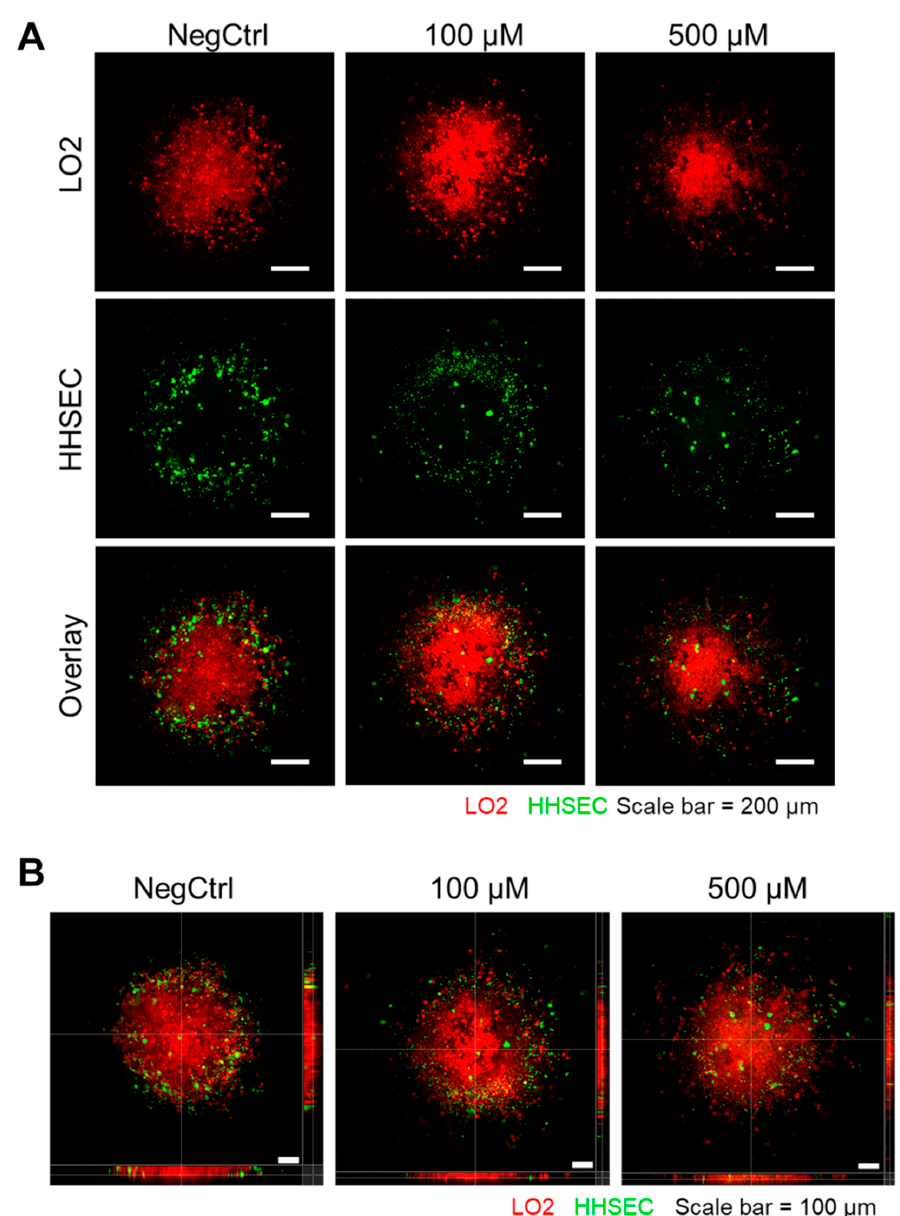
Figure 5. TiO 2 NPs disrupted the 3D co-culture model of normal human hepatic cells LO2 and HHSECs. ( A ) LO2 cells were stained with CellTracker orange (red) while HHSECs were stained with CellTracker green (Green). TiO 2 NP treatment resulted in the dispersion of both LO2 and HHSECs away from the core structure. Scale bar = 200 µm. ( B ) Z-stacking of multiple images to reveal a cross-section of the 3D structure showed the absence of HHSECs surrounding the LO2 cells upon exposure to TiO 2 NPs. Scale bar = 100 µm.